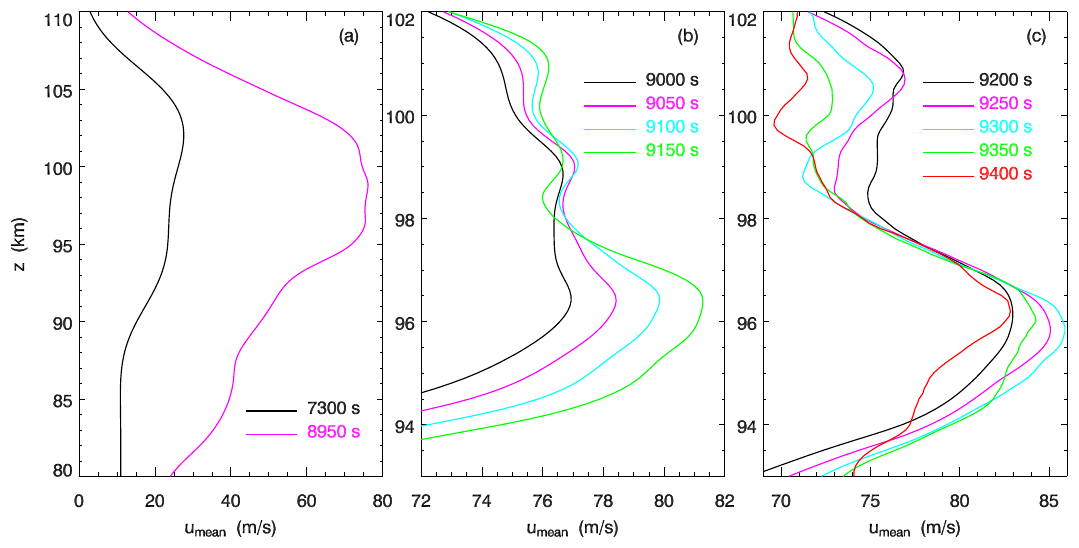
Fig. 5. Vertical profiles of mean wind at several times during the process of KH billows